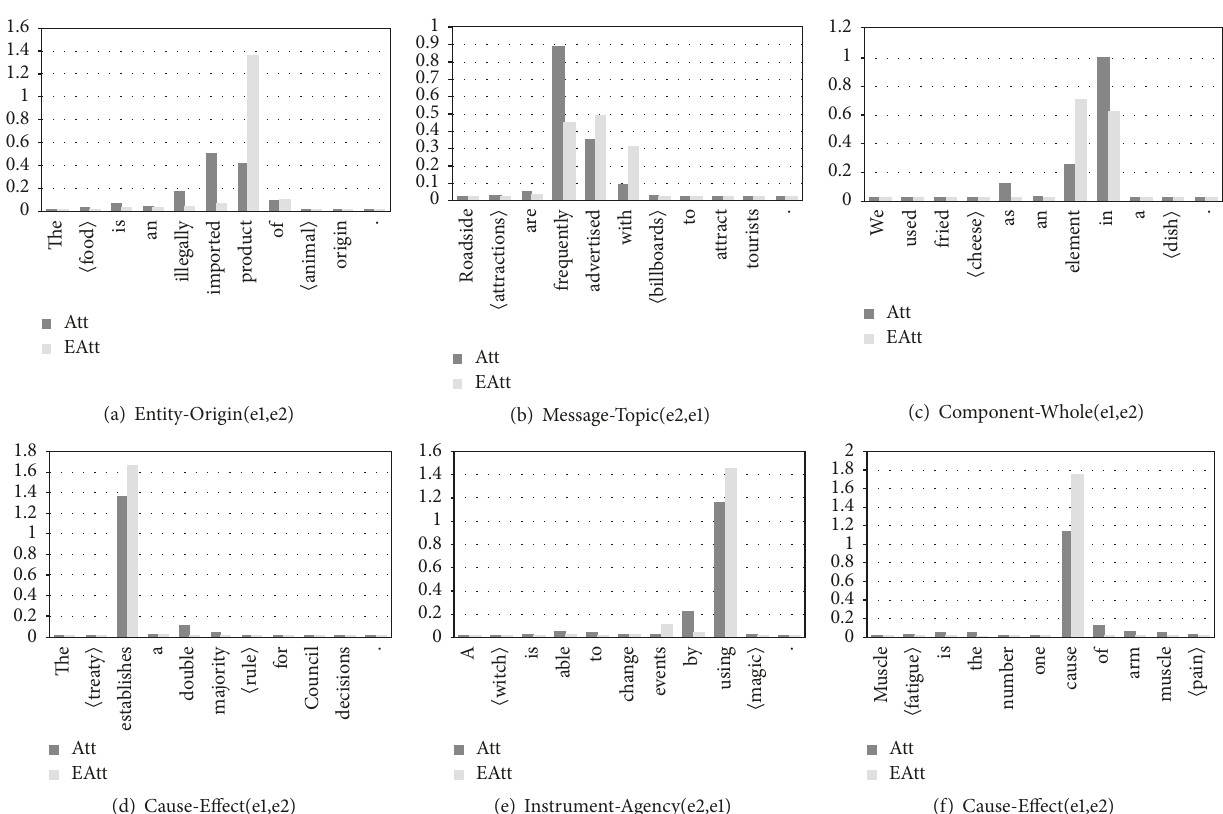
Figure 3. For better visual effect, the actual attention weight 𝑒 𝛼 𝑖 − 0.98 ). In 𝛼 𝑖 is adjusted according to the formula ( addition, the entity pair is annotated with angle brackets in horizontal coordinate. These 6 histograms can be divided into two cases: histograms (a) ∼ (c) demonstrate that two attention mechanisms give the highest attention weight for different words, but histograms (d) ∼ (f) present the case that the same word is assigned the highest weight but the numeric values are different. In the first case, combining the annotated sentences with the relation types, it is easy to find that